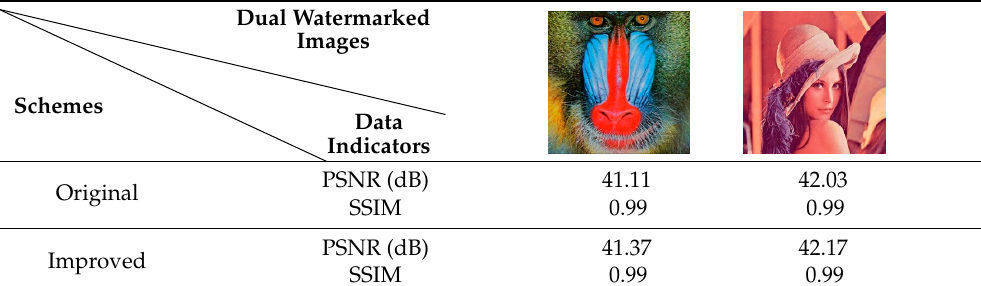
Table 2. Comparison results of PSNR and SSIM between the improved scheme and the original scheme [35].